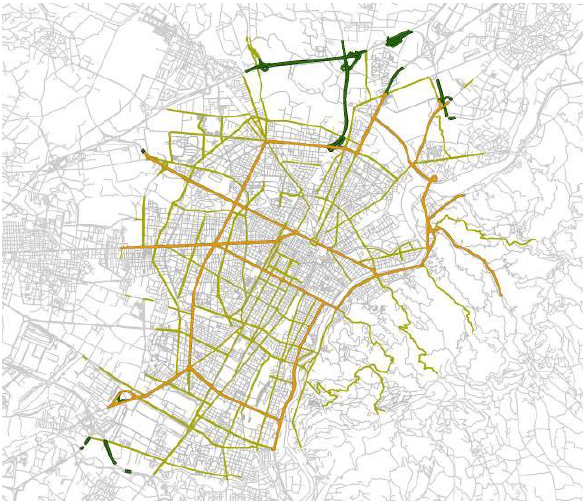
Figure 3. OTM road network within the Torino municipality area, symbolised on functional classes (green = motorways, orange = first class, yellow = second/third classes, grey = other